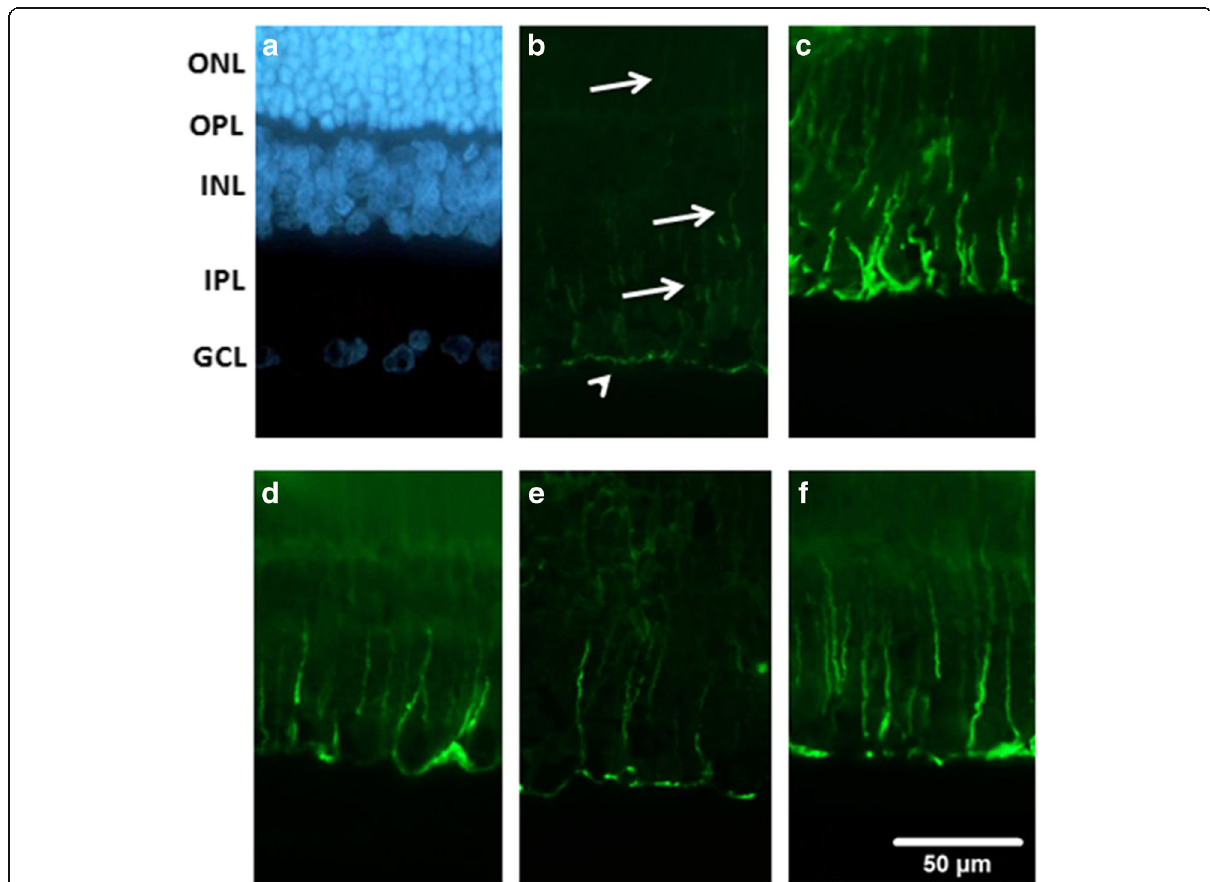
Fig. 5 Glial fibrillary acidic protein (GFAP, green) immunohistochemistry. a is the cellular nucleus of the sham retina labeled with 4,6-diamidine-2- phenylindole dihydrochloride (DAPI, blue); b shows Müller cells labelled with GFAP immunoreactivity at the end feet (arrow head) in the GCL and at the processes in the IPL, INL and ONL (arrows). c shows a retina that received I/R and preischemia adminstration of vehicle; there is an increase in anti-GFAP immuolabeling. ( d , e , f ) are sections from the retinas that received I/R and preischemia administration of 1.35 g/kg/day XFZYD ( d , XFZYD 1.35 + I/R), 2.7 g/kg/day XFZYD ( e , XFZYD 2.7 + I/R) or postischemia administration of 2.7 g/kg/day XFZYD ( f , I/R + XFZYD 2.7 ). Moreover, this ischemia-associated alteration was obviously and dose-dependently mitigated as ischemic retinas were preadministrated with 1.35